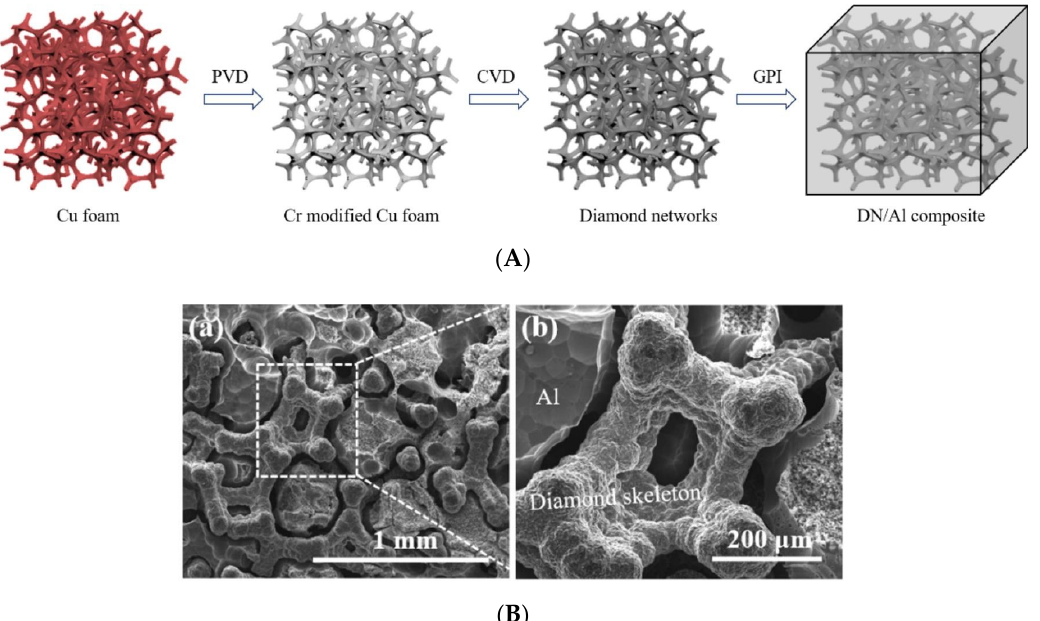
Figure 9. ( A ) Schematic illustration of the fabrication process of the diamond network/Al composite, ( B ) SEM morphologies of the diamond network/Al composite [134].